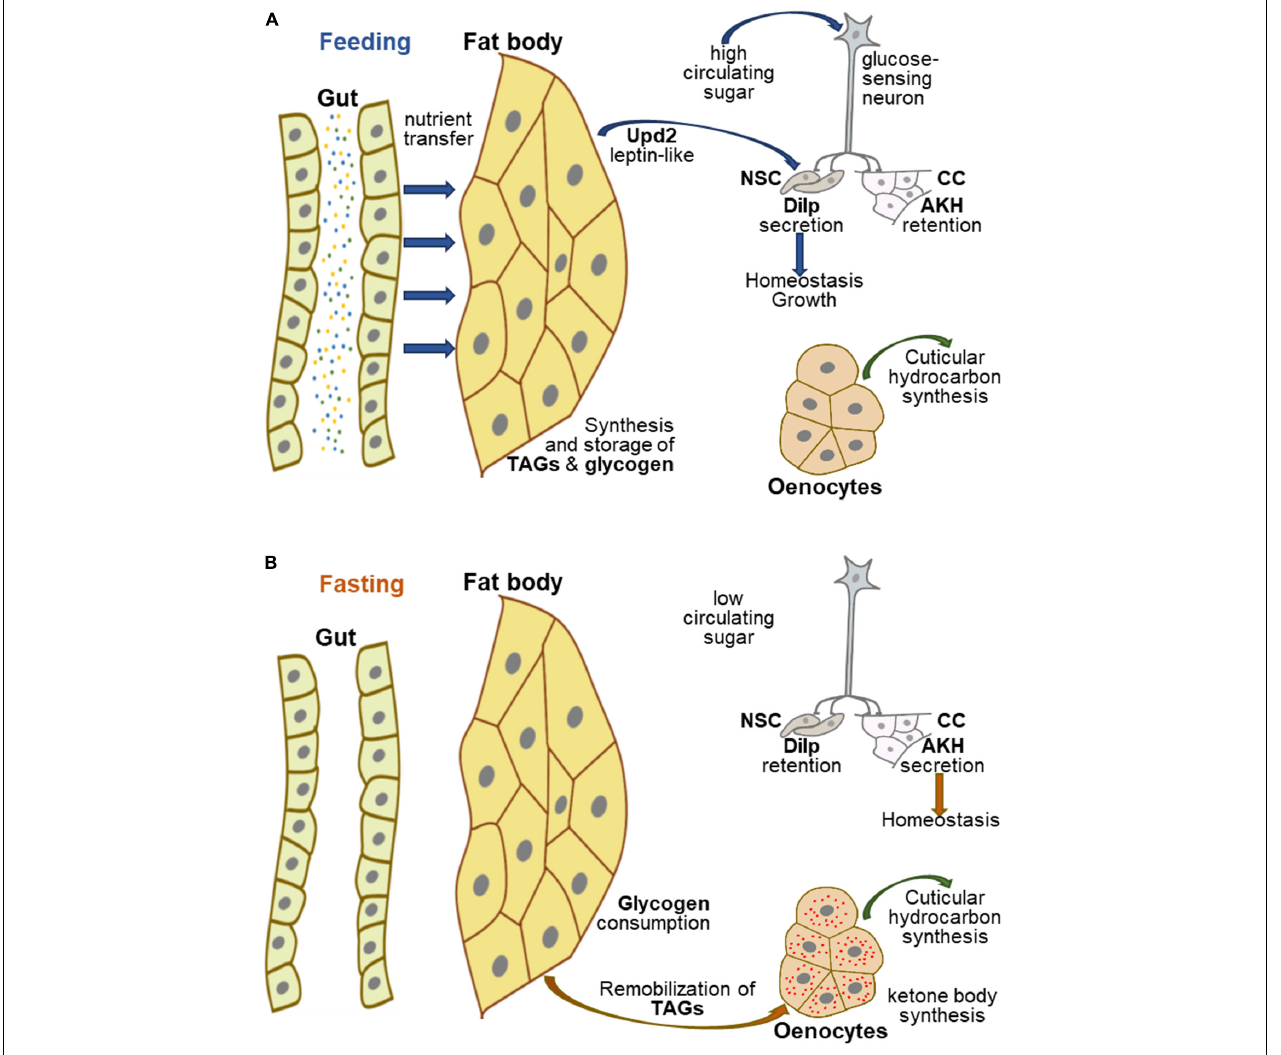
FIGURE 1 | Hepatic-like homeostasis in Drosophila . (A) In fed Drosophila , nutrients are transferred to the appropriate organs, in particular the FB, which acts as a nutrient sensor to coordinate organismal growth and homeostasis. The FB synthesizes and stores glycogen and TAGs, and secretes several proteins, including Upd2, which can be replaced experimentally by mammalian leptin; Upd2 and glucose-sensing neurons contribute to regulating the secretion of Dilps and AKH to control growth and homeostasis. (B) In fasting Drosophila , FB glycogen and TAGs are remobilized, the latter being transferred to the oenocytes to produce ketone bodies, while glucose sensing neurons potentiate AKH secretion and Dilp retention in neurosecretory cells to maintain